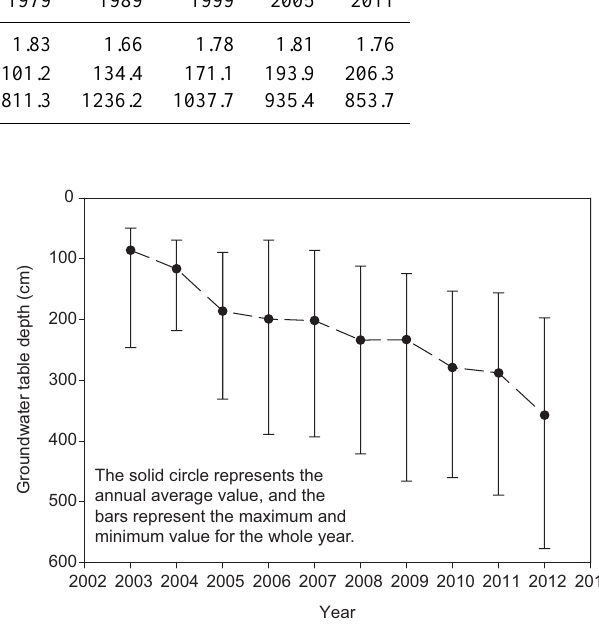
Figure 10. Long-term groundwater table variation in Yanqi County in the